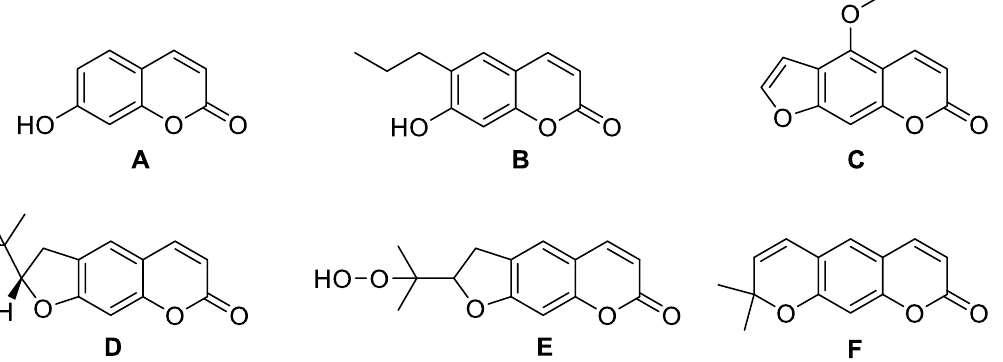
Figure 13. Chemical structures of umbelliferone ( A ), phelodenol ( B ), bergaptene ( C ), marmesin ( D ), rutaretin ( E ), and xanthyletin ( F ).